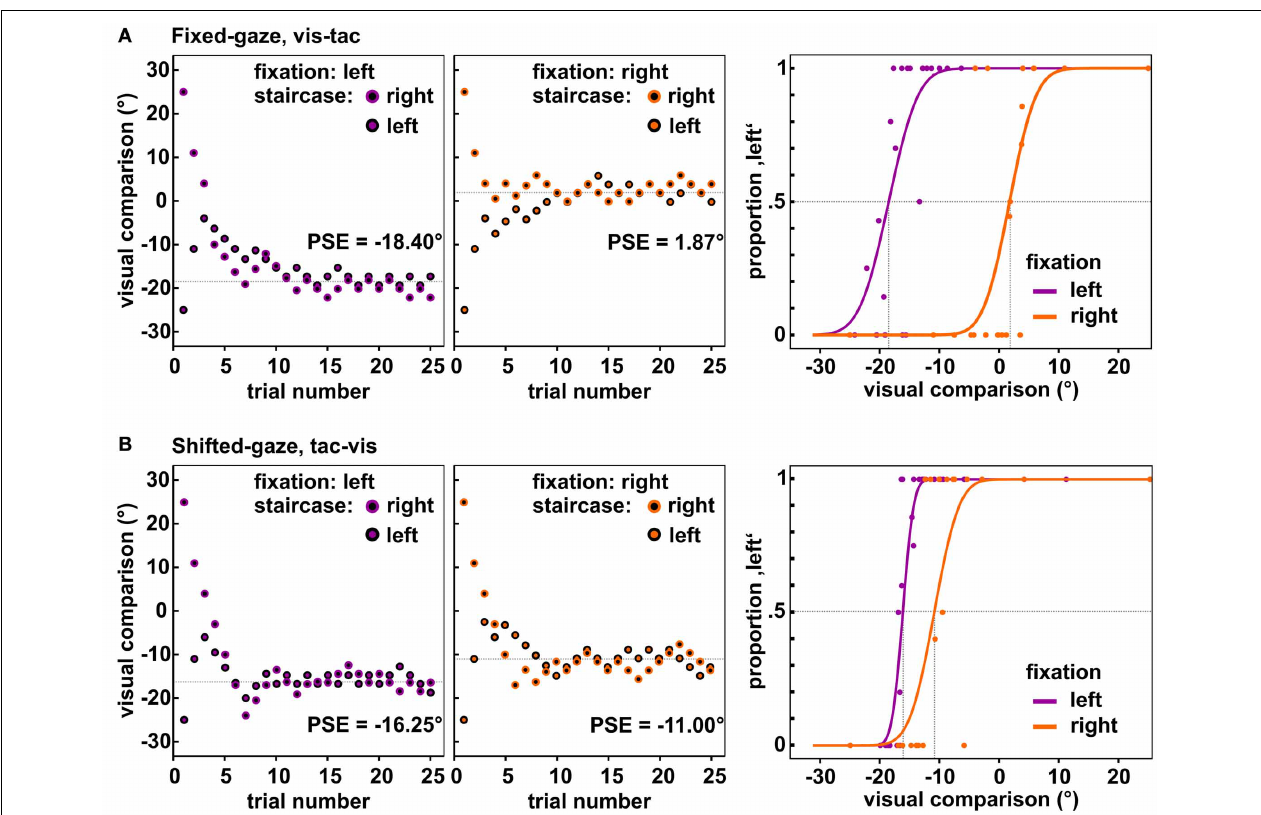
FIGURE 3 | Observed data of one subject for the central standard location. Depicted are the locations of the visual comparison presented in each trial of the two staircases when fixating to the left (1st panels) and to the right (2nd panels). Each staircase comprised 25 trials, resulting in 50 trials per fixation-standard combination. Over the course of trials the two staircases approached the PSE (dashed line). The 3rd panel in each row shows the resulting psychometric functions fitted to the responses collapsed